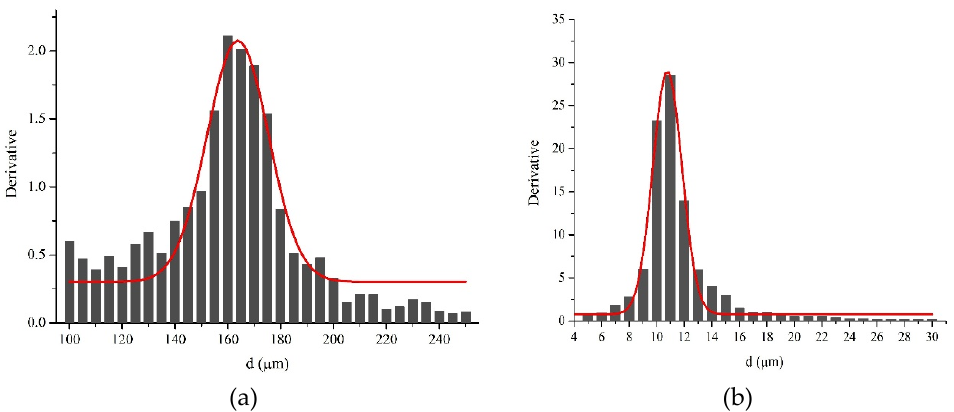
Figure 1. The histograms of the distribution of ilmenite particles in size: ( a ) before grinding; ( b ) after grinding for 2 h.